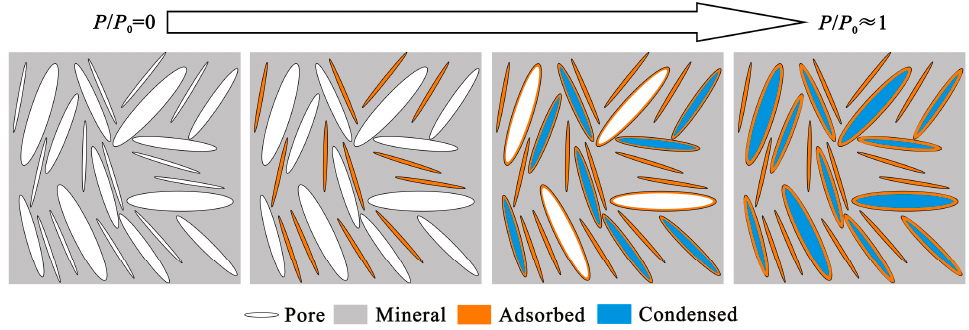
Figure 1. Schematic of the adsorption and condensation of hydrocarbon with increasing relative pressure.